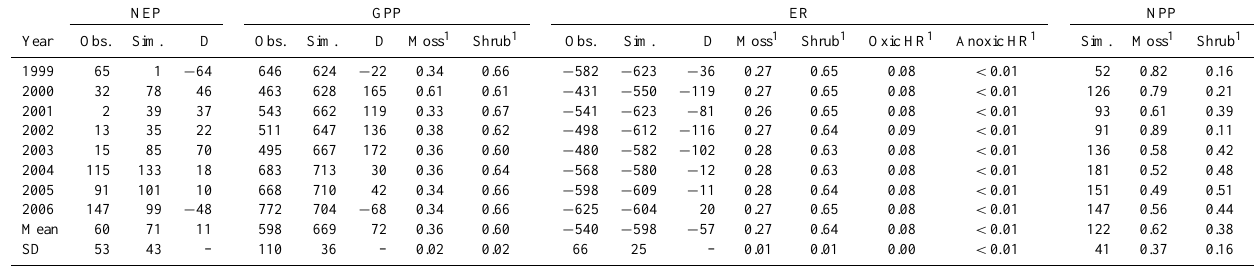
Table 2. Observed (Obs.), simulated (Sim.), and the difference (D) between observed and simulated ( 1 ) annual NEP, GPP and ER for 8 years for the Mer Bleue peatland. The exchanges are expressed in gCm − 2 yr − 1 and the superscripts on moss and shrub GPP, ER and NPP and the HR components of ER indicate their fractional contribution. SD refers to the standard deviation. NEP GPP ER NPP Year Obs. Sim. Obs. Sim.